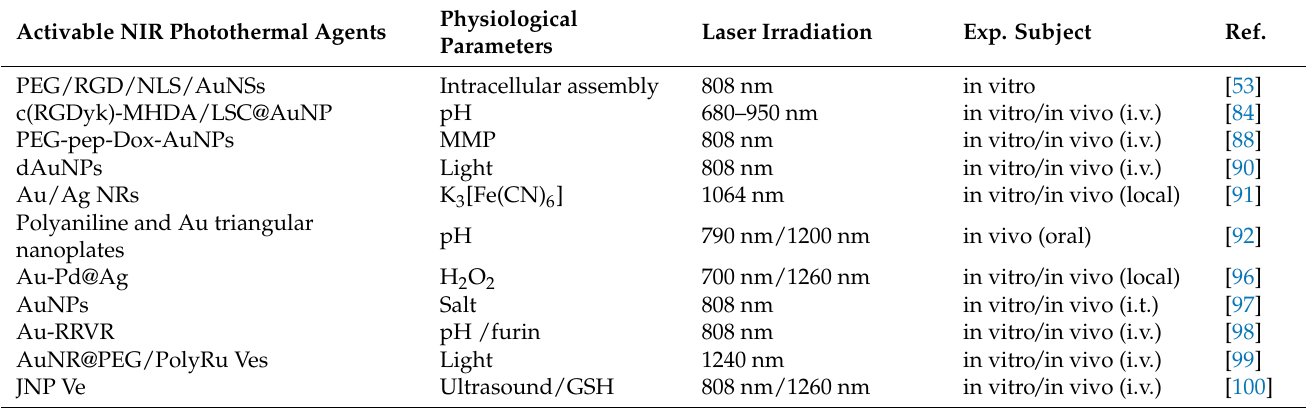
Table 3. Summary of recent reports on activatable gold nanomaterials for PA